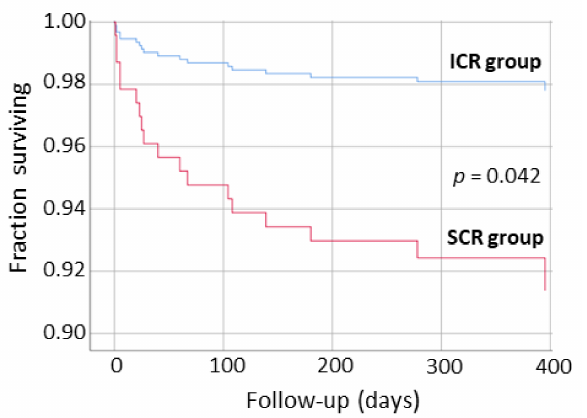
Figure 2. Kaplan-Meier analysis showing survival free from hospitalization for heart failure in long-term follow-up after discharge from intensive cardiac rehabilitation (ICR group) and standard cardiac rehabilitation (SCR group)